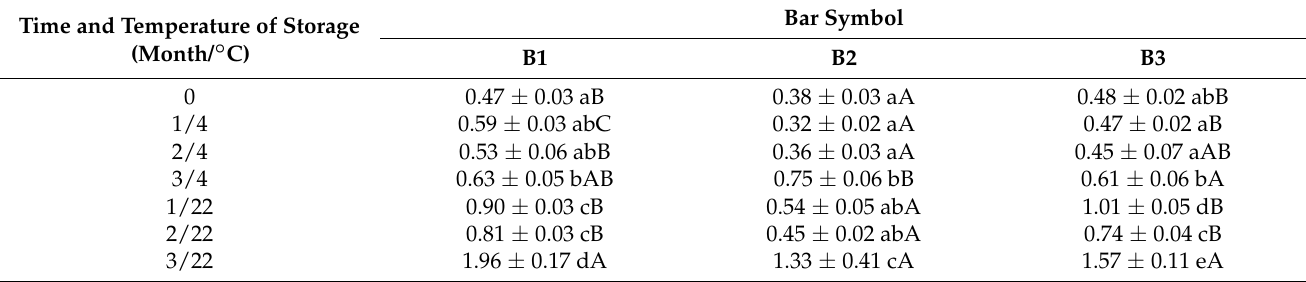
Table 5. The value of the bar TBARS index (mg